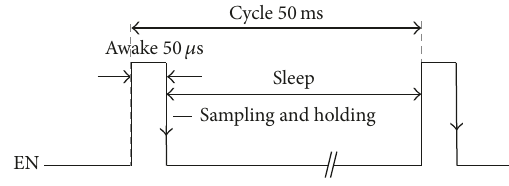
Figure 9: Low-power clock control